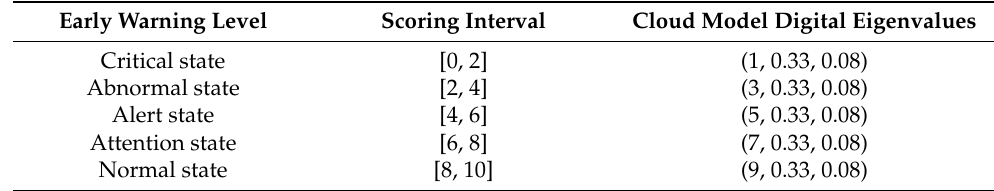
Table 10. Numerical eigenvalues of the cloud model for ETL status warning level scoring intervals.